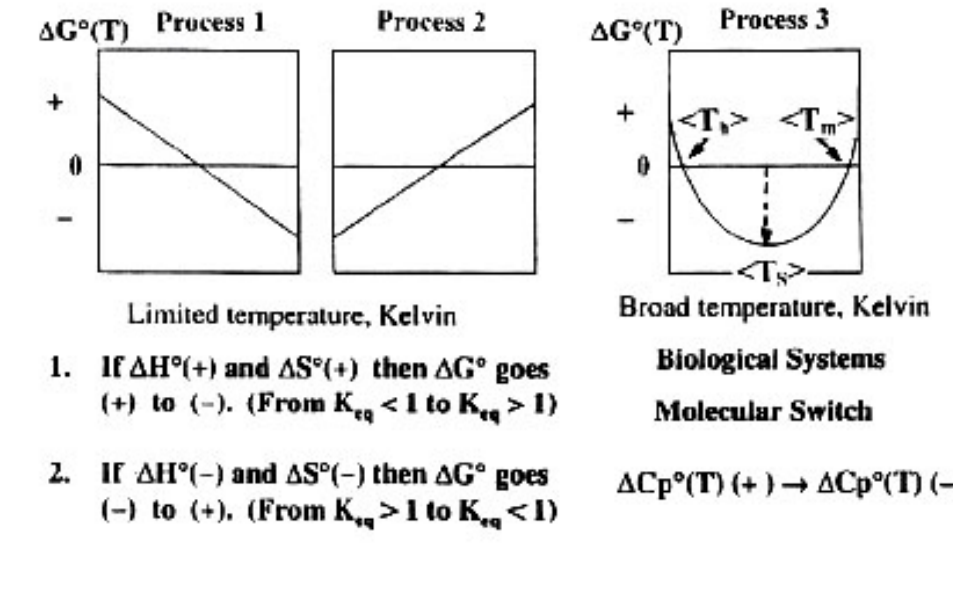
FIGURE 1 . In all biological interactions, ∆ H o (T) and ∆ S o (T) are positive at low temperature. As reaction temperature increases, both ∆ H o (T) and ∆ S o (T) become negative, creating negative Gibbs free energy minimum: that is process 1 of the chart goes to process 2, creating process 3 (see Table 1). The change of sign in ∆ Cp o (T) reaction leads to a true negative minimum in the Gibbs free energy of reaction, that is ∆ Cp o (+) → ∆ Cp o (–), designated as a thermodynamic molecular switch. It determines the behavior patterns of the Gibbs free energy change, and hence a change in the equilibrium constant, K eq , and/or